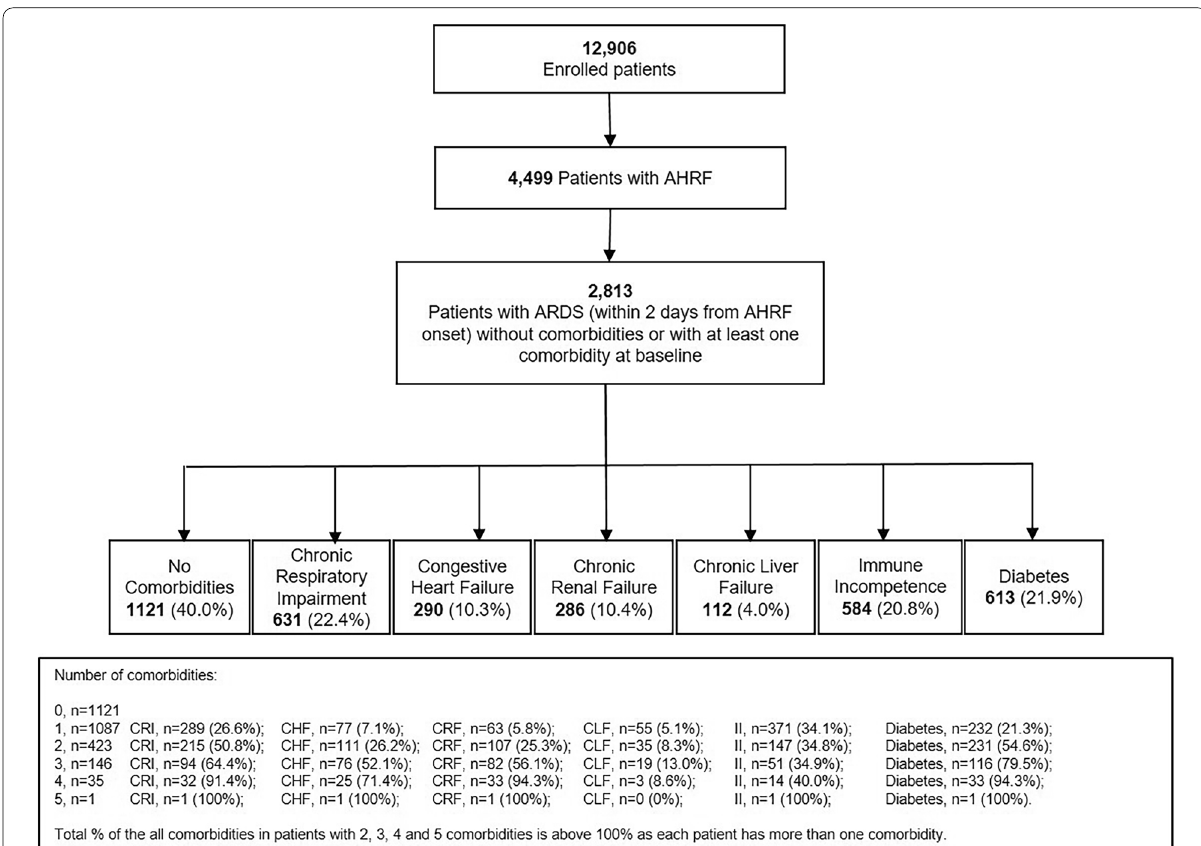
Fig. 1 Selection of patients for study population. Patients with more than one comorbidity will be classified on the basis of each comorbidity that they